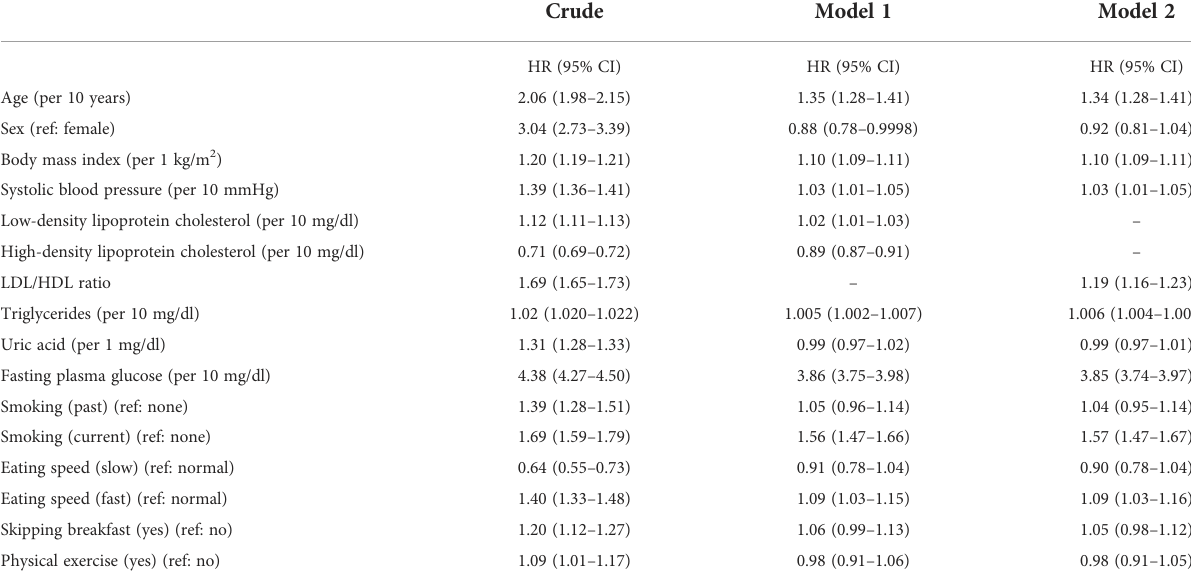
TABLE 2 Unadjusted and adjusted hazard ratios for incidence of diabetes during the 10-year follow-up period.